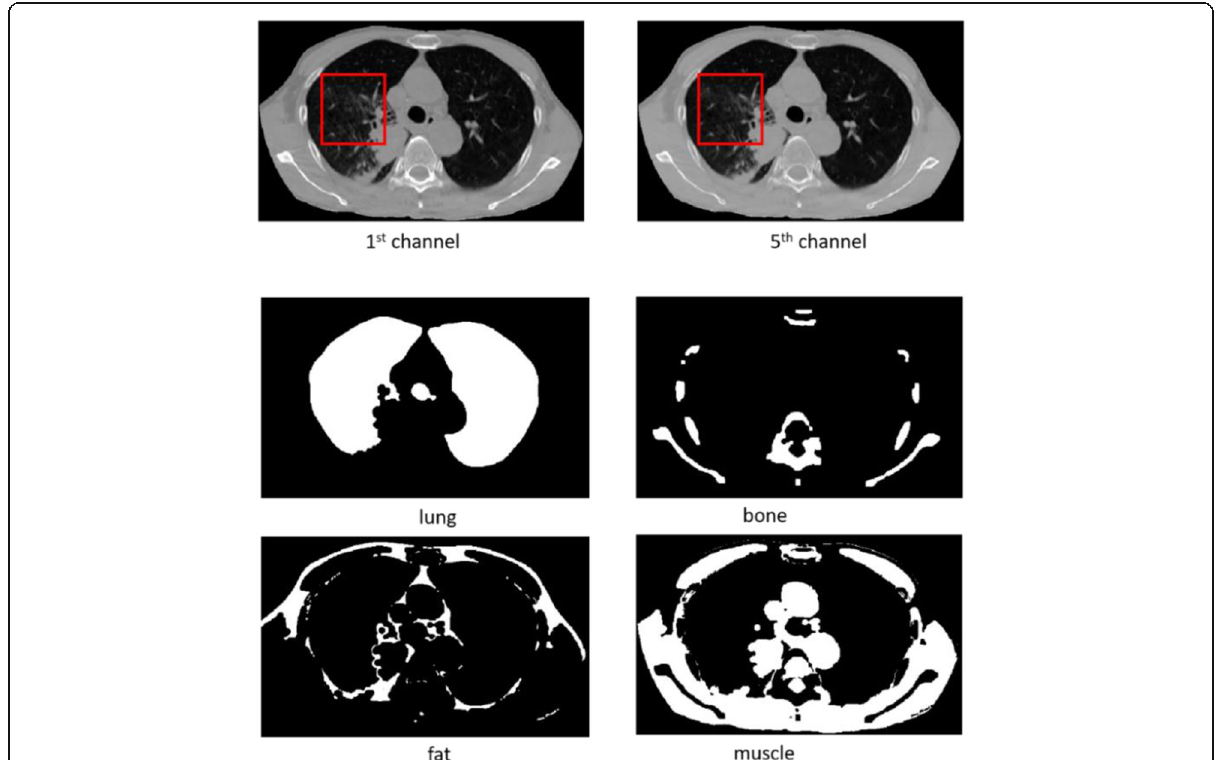
Fig. 1 Full dose computed tomography images and their segmented tissue masks. Images of first and last (5th) energy channel. Tissue masks of lung, bone, fat and muscle